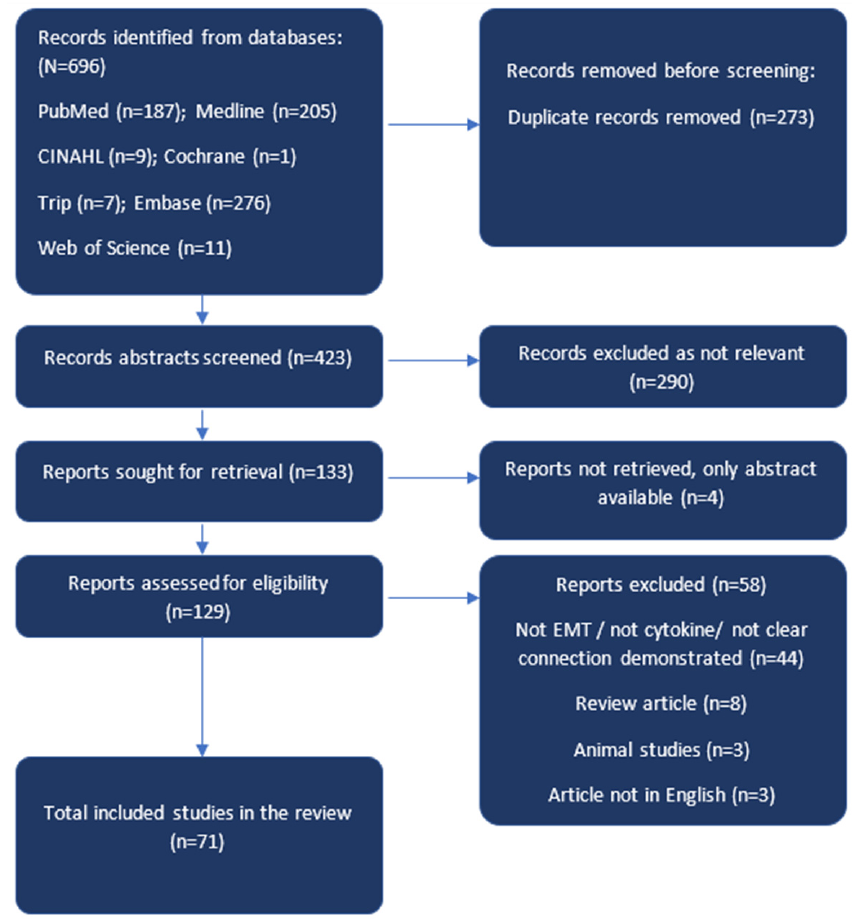
Figure 1. Flow diagram showing the stepwise process of screening, exclusion, inclusion, and analysis of articles as per the Preferred Reporting Items for Systematic Reviews and Meta Analyses Protocols (PRISMA) 2020 [32] guidelines.